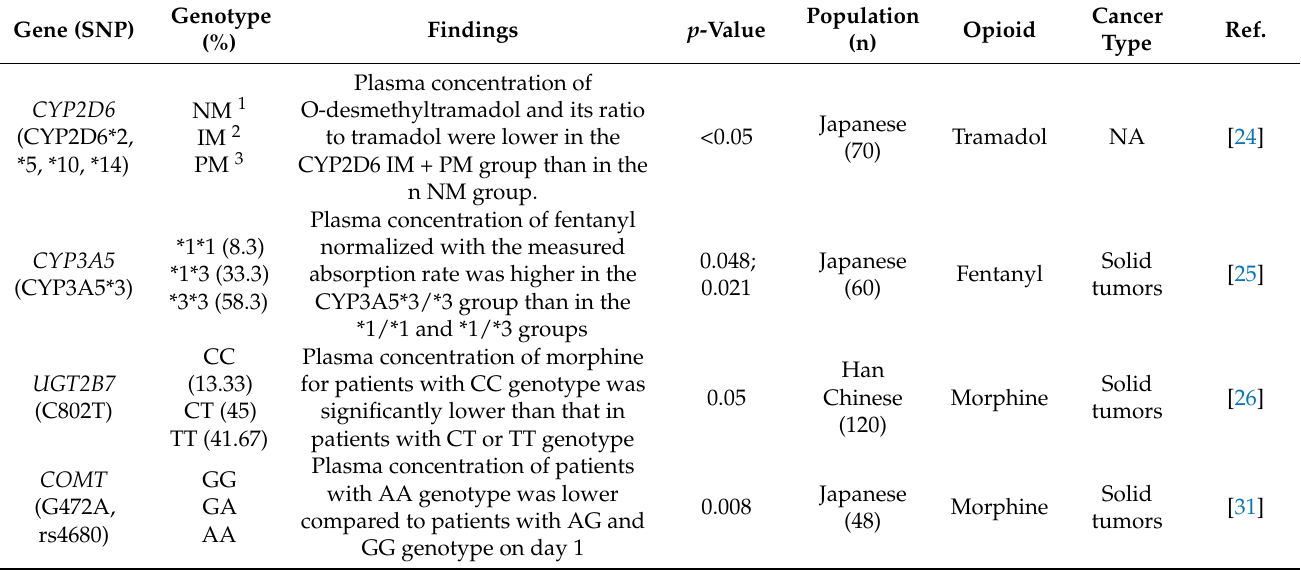
Table 3. Polymorphisms significantly associated with opioid pharmacokinetics in cancer pain among Asian populations.